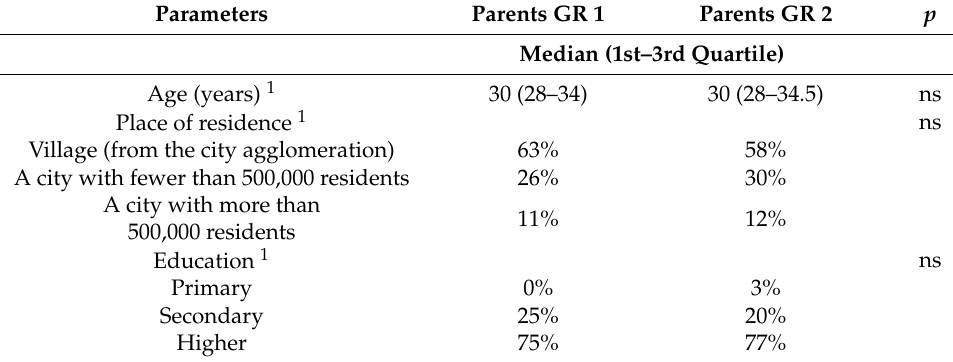
Table 1. Data concerning parents’ age, education and place of